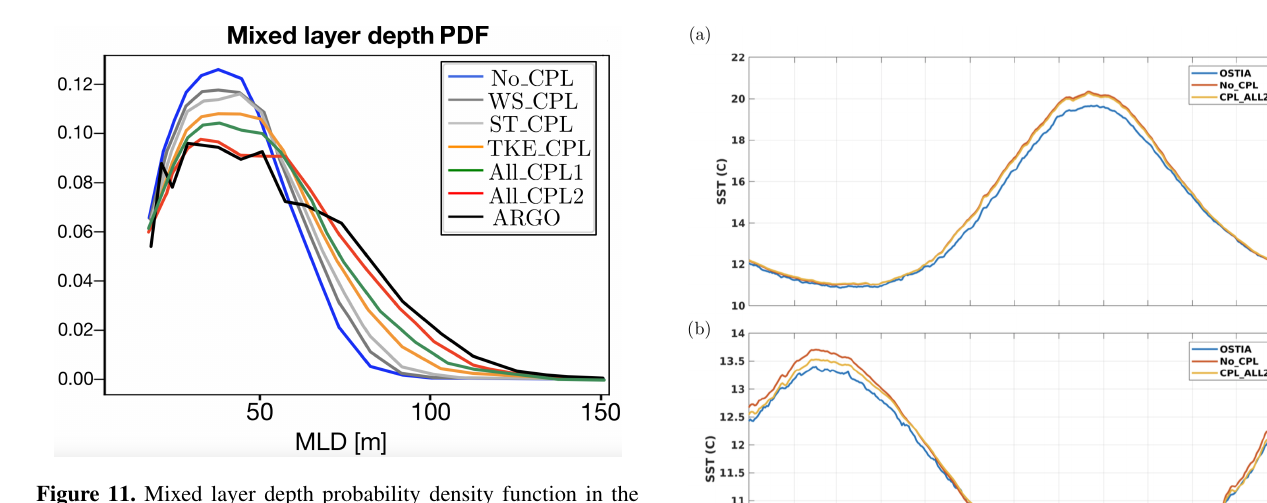
Figure 11. Mixed layer depth probability density function in the Southern Hemisphere during summer months. The details of each experiment can be found in Table 2.